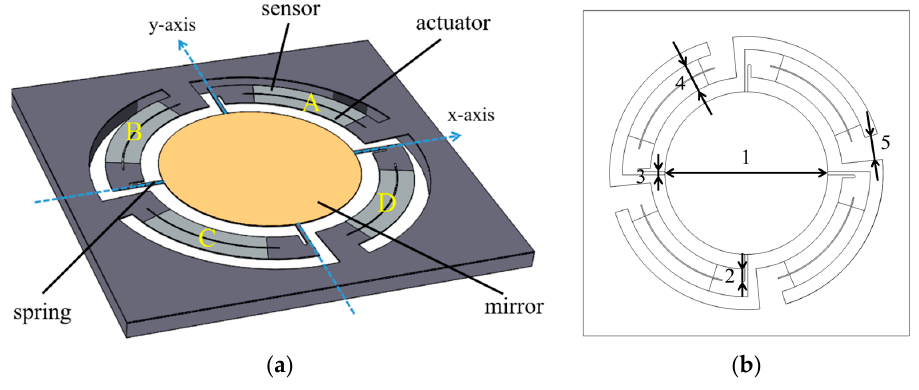
Figure 1. ( a ) The structure of Design Ⅰ . ( b ) Design Ⅰ parameter index.